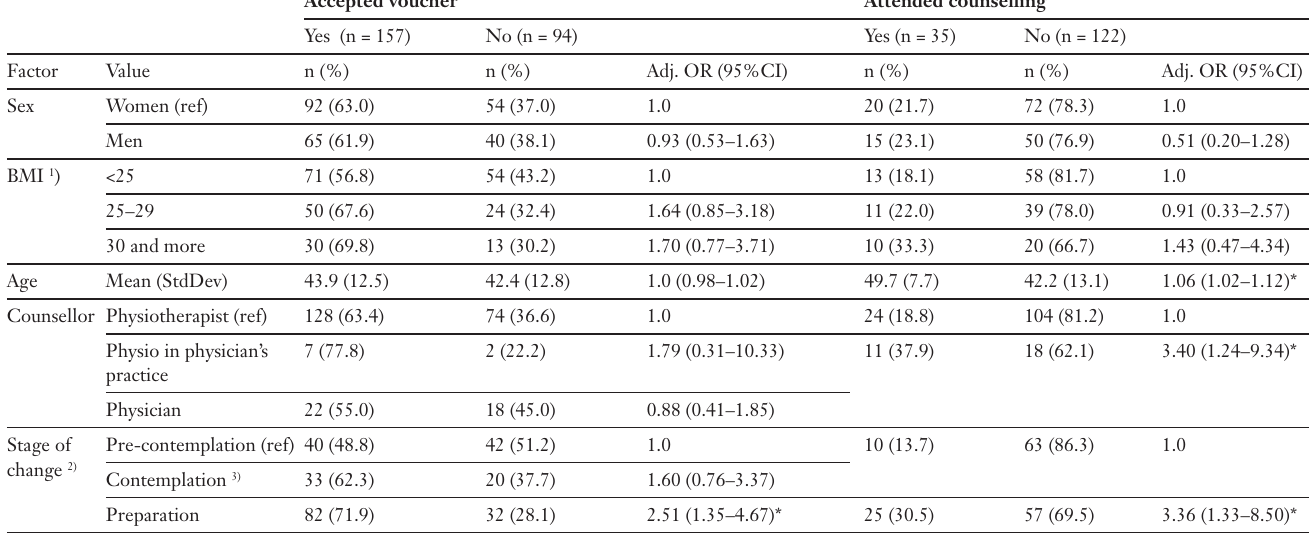
Acceptance of voucher and attendance at physical activity